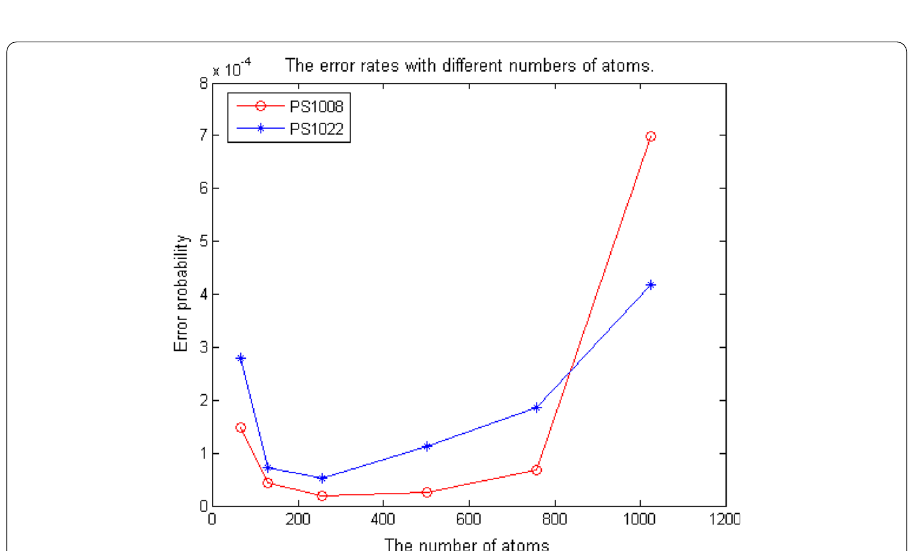
Fig. 12 Error probability versus the number of atoms in each dictionary when using the DL (proposed)